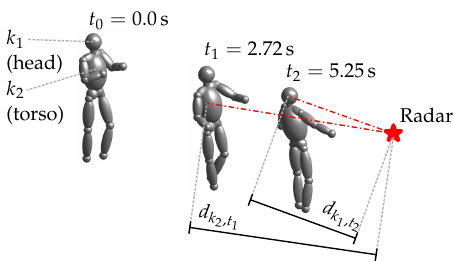
Figure 5. Human posture with respect to the radar at different times, as modeled by Boulic et al.